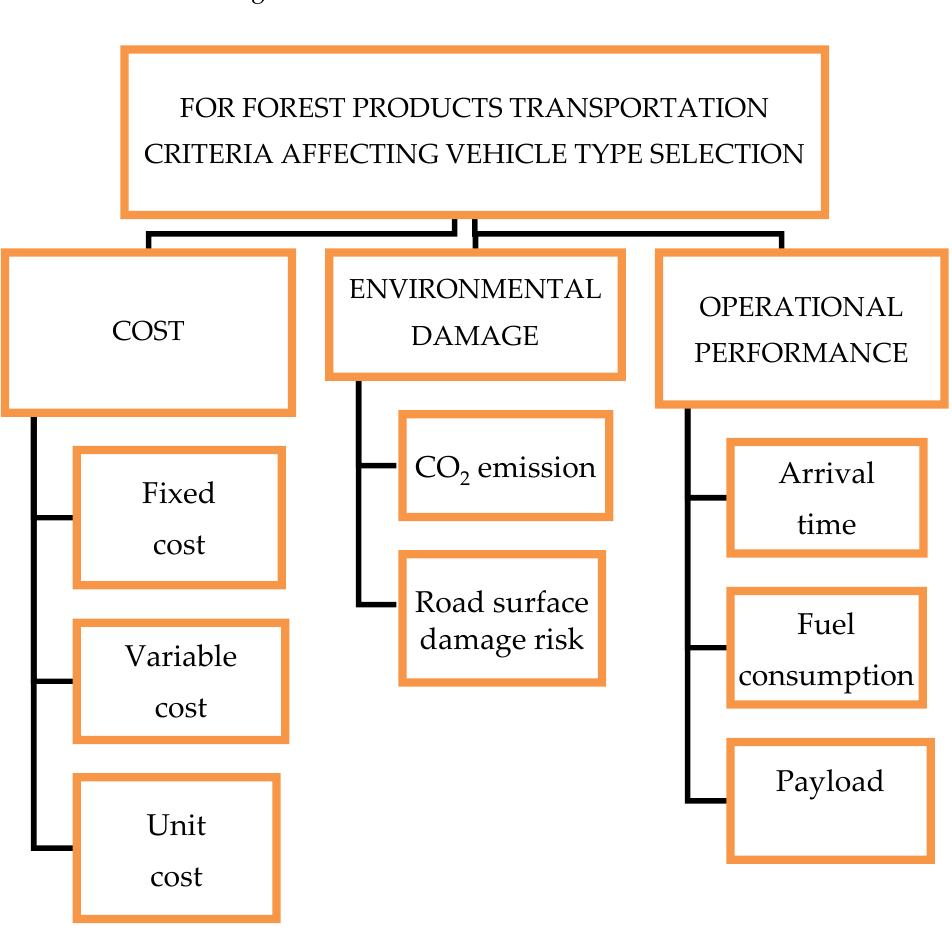
Figure 4. Hierarchical structure of main criteria and sub-criteria for vehicle type selection. Table 2. Demographic characteristics of the persons participating in the questionnaire.